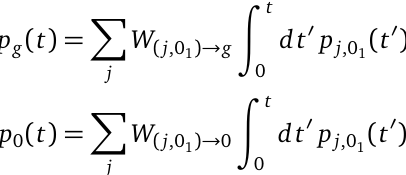
( t ) and the occupation p ( dir . ) ∞ g = 4 J ( 1 ) = 8 B and N = 40 (see Fig. 9). The vertical x x (cid:48) (see text and gap